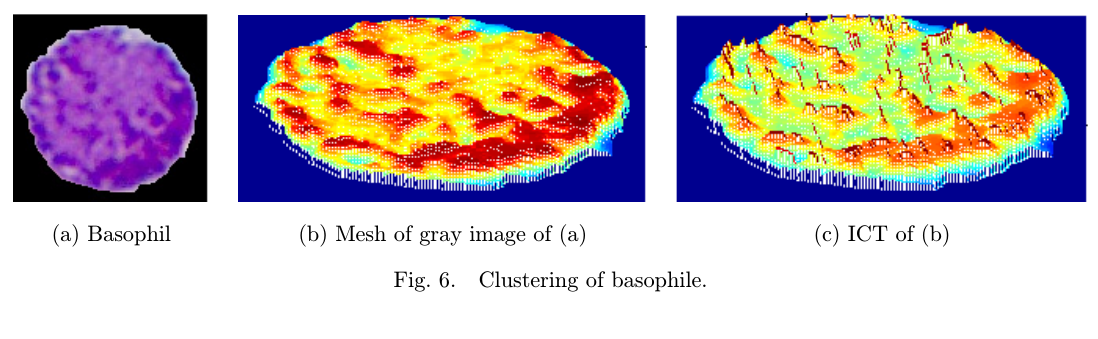
Fig. 6. Clustering of basophile.